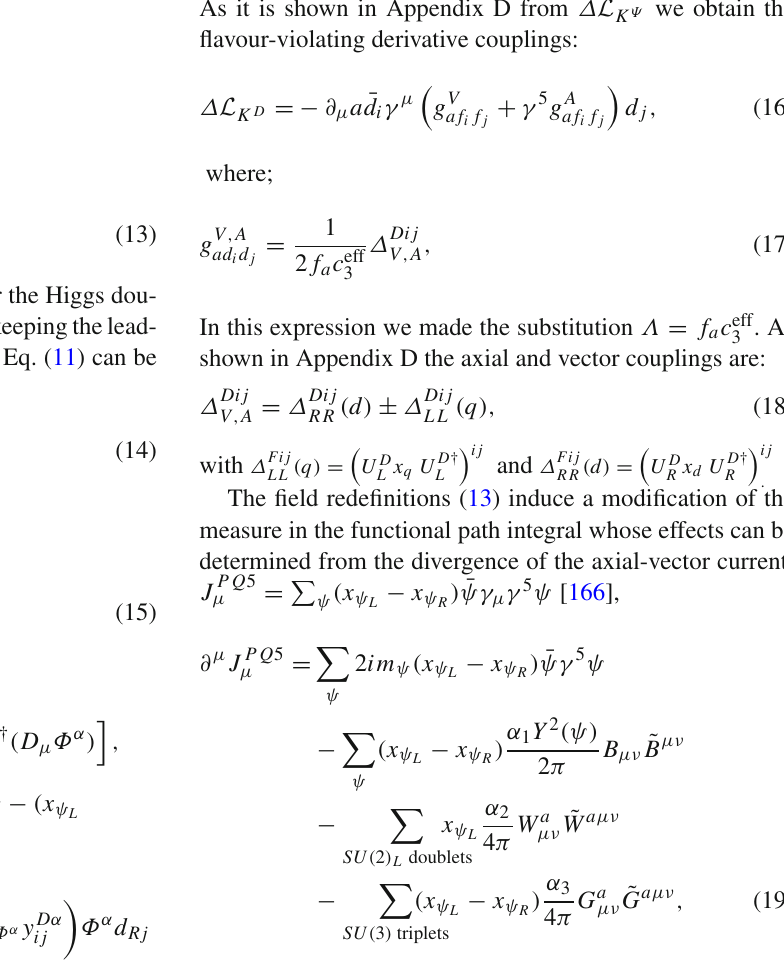
quarks for the three families i = 1 , 2 , 3 i